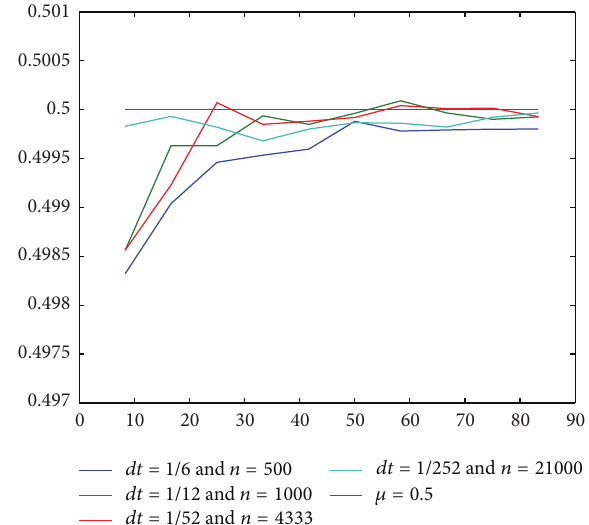
Figure 2: 𝜇 estimation results. 𝑑𝑡 = 1/6, 1/12, 1/52, and 1/252, 𝑛 = 500, 1000, 4333, and 21000,